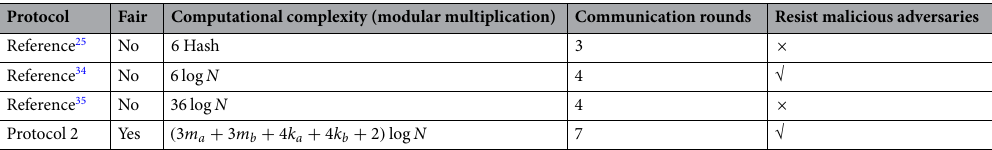
Table 1. The overall performance comparison of each protocol.